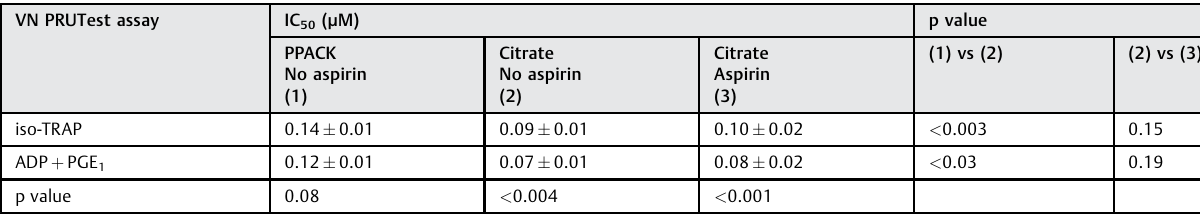
Table 1 IC 50 s (mean (cid:4) SD) of RUC-4 in PPACK- and sodium citrate-anticoagulated blood fromvolunteers who were either not taking or taking